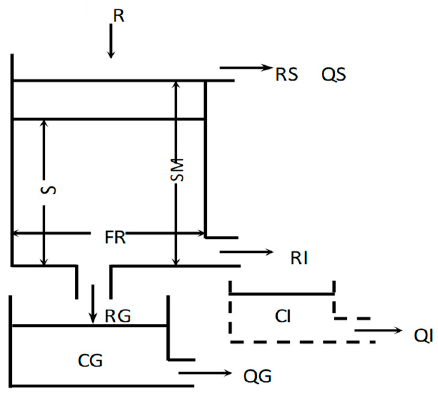
Figure 3. A diagrammatic sketch of the structure of “Free water reservoir” (with such a nonfigurative structure, the runoff generation can be partition based on the runoff components.).